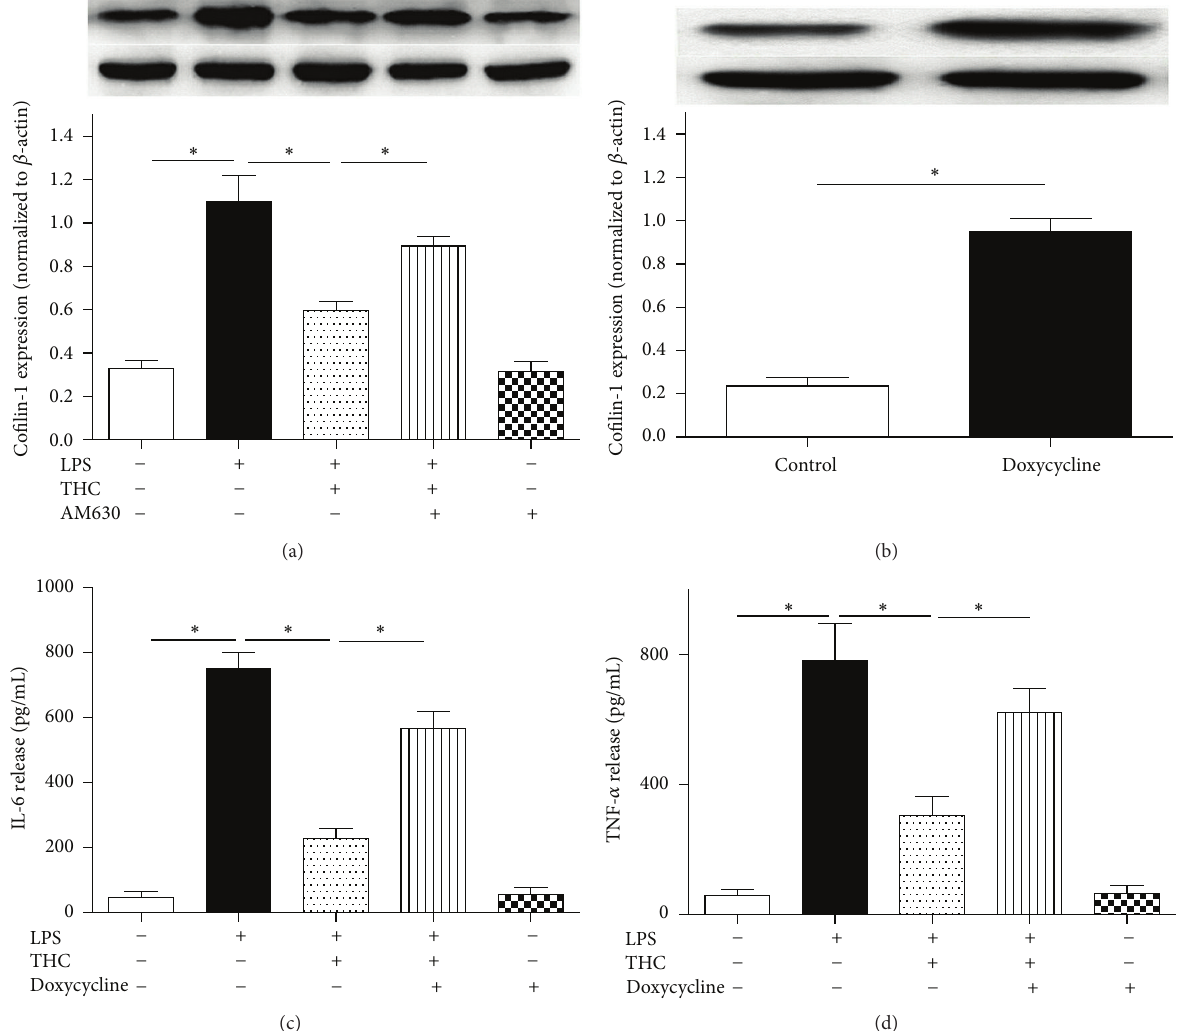
Figure 7: The upregulation of cofilin-1 inhibited the THC-induced anti-inflammation. (a) CB2 antagonist reversed the THC-induced effect on cofilin-1 expression. (b) Doxycycline induced an overexpression of cofilin-1 in the MG-63 cells. (c) Doxycycline abolished THC-induced reduction of IL-6 release. (d) Doxycycline abolished the THC-induced reduction of TNF- 𝛼 release. The cells were treated with different drugs for 24 h (LPS: 10ng/mL; THC: 5 𝜇 M; AM630: 10 𝜇 M; doxycycline: 0.1 𝜇 g/mL), western blot was performed to evaluate the cofilin-1 expression, and ELISA was used to test the concentrations of IL-6 and TNF- 𝛼 in the supernatants. Results are means ± SD ( 𝑛 = 6 ). ∗ : 𝑃 < 0.05